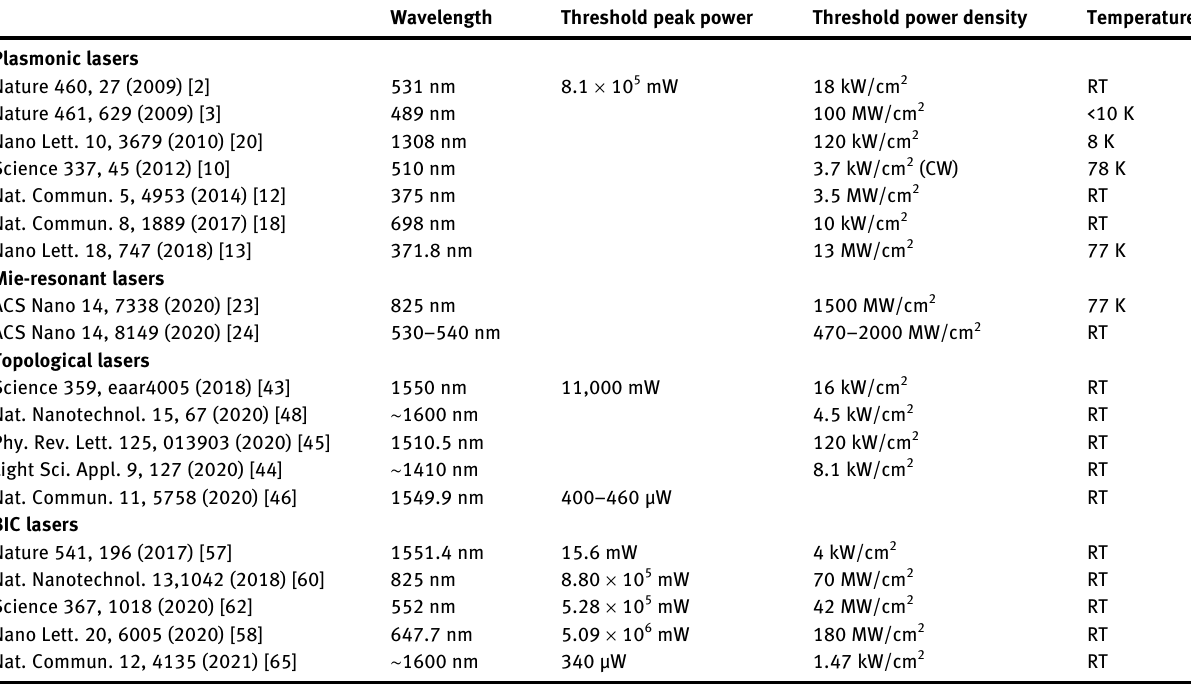
Table  : A summary of the properties of some plasmonic and nonplasmonic nanolasers.